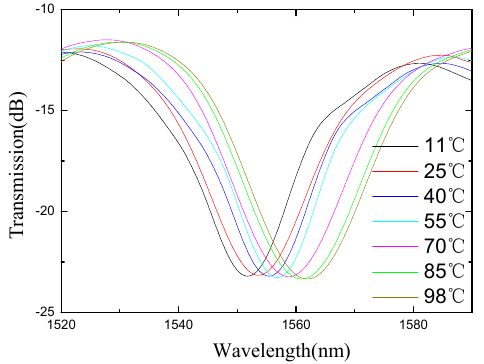
Figure 11. The spectra under different ambient temperatures.